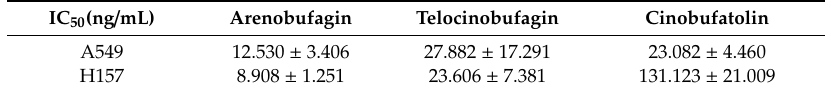
Table 9. The inhibitory e ff ects of bufadienolides on A549, H157 cells.